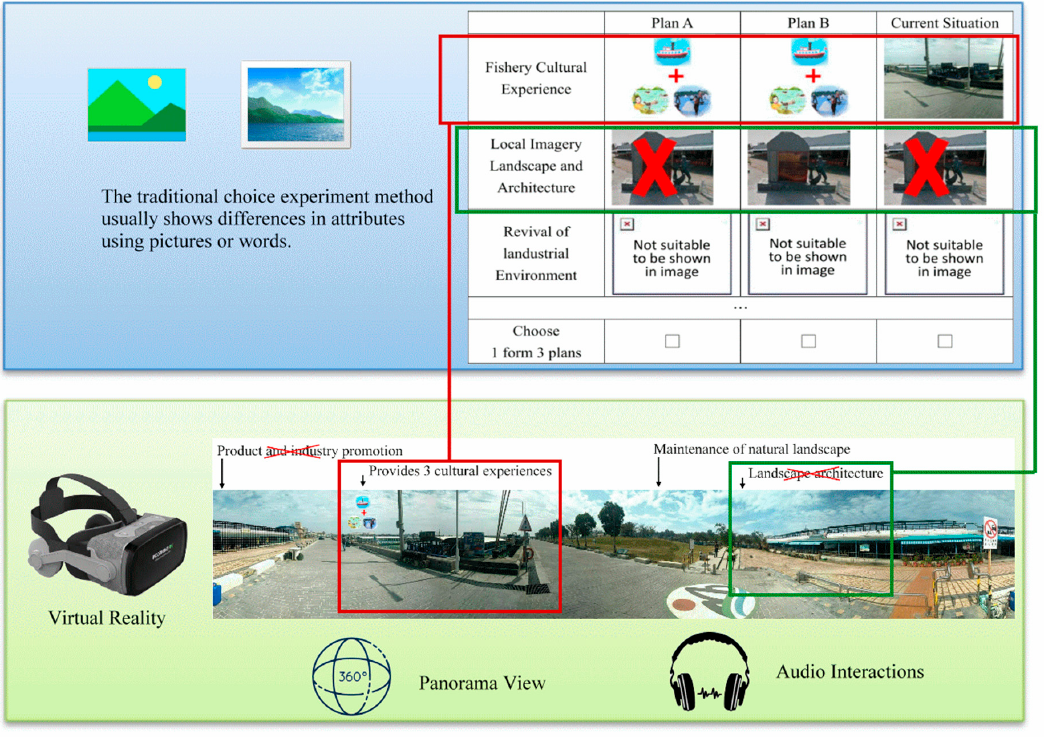
Figure 2. Observed differences between the traditional choice experiment method and after the use of virtual reality tools.